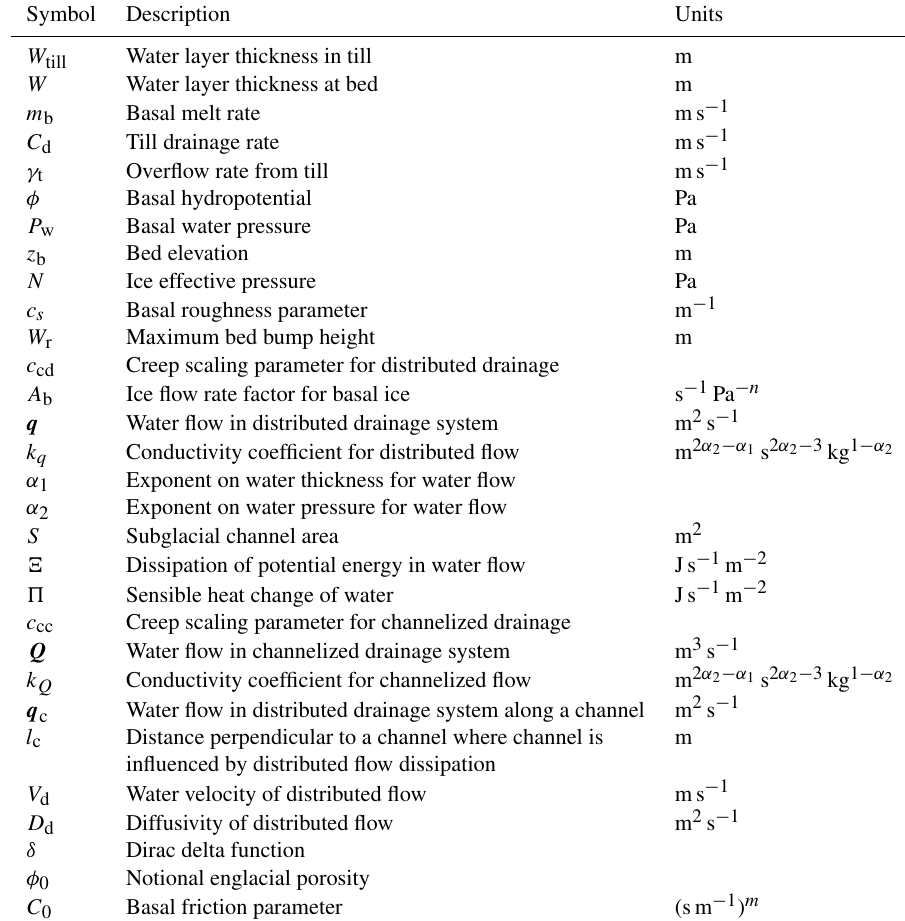
Table A5. Subglacial hydrology variables and parameters.